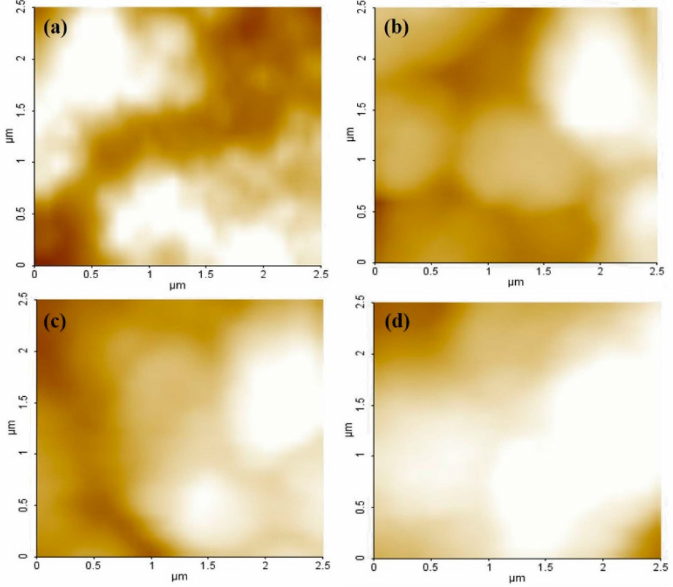
Figure 6. AFM image of HPL deposited on the PEDOT:PSS layer according to the concentration of